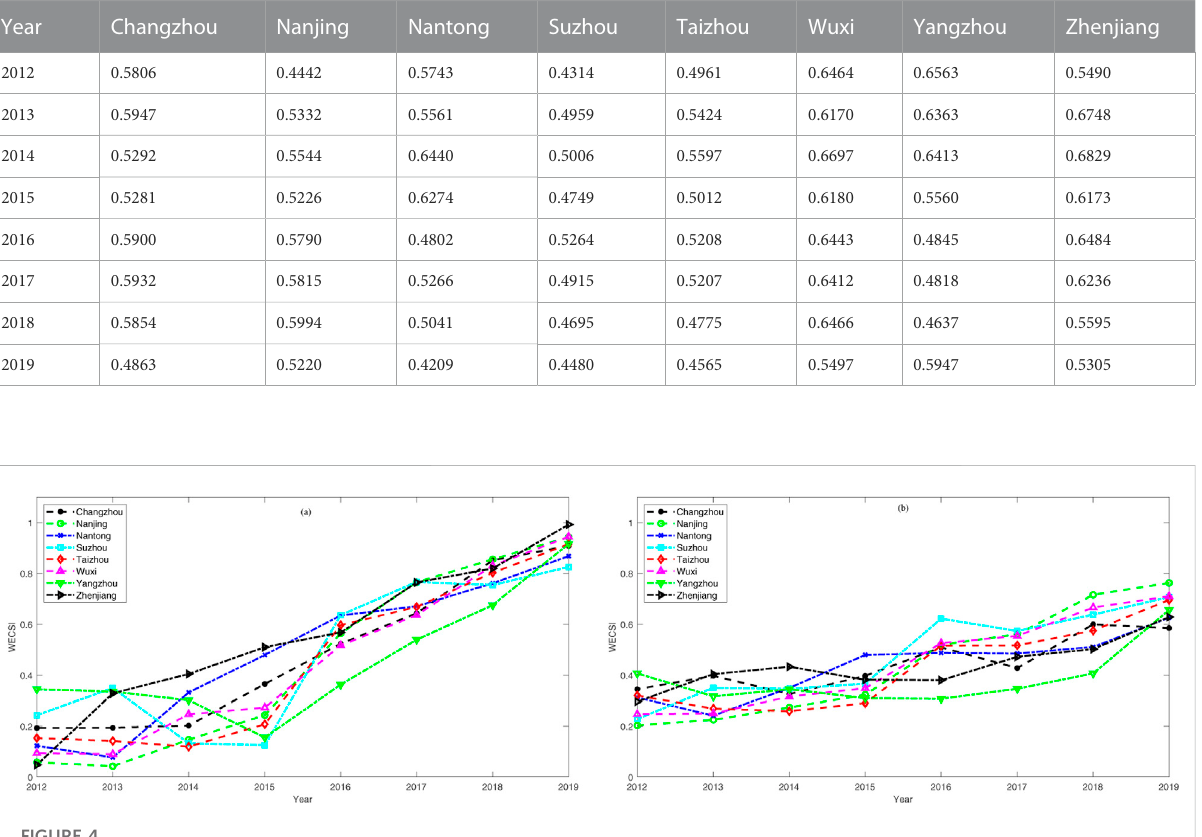
Table 9. The major in fl uence factors of annual WECS obtained by the PP method and EW method were quite different. Table 8 are urbanization rate (UR), GDP, daily domestic water consumption per capita (DDW), amount of fertilizer used in agriculture (AFA), industrial sewage discharged (ISD), COD discharge in industrial sewage (CIS), ammonia